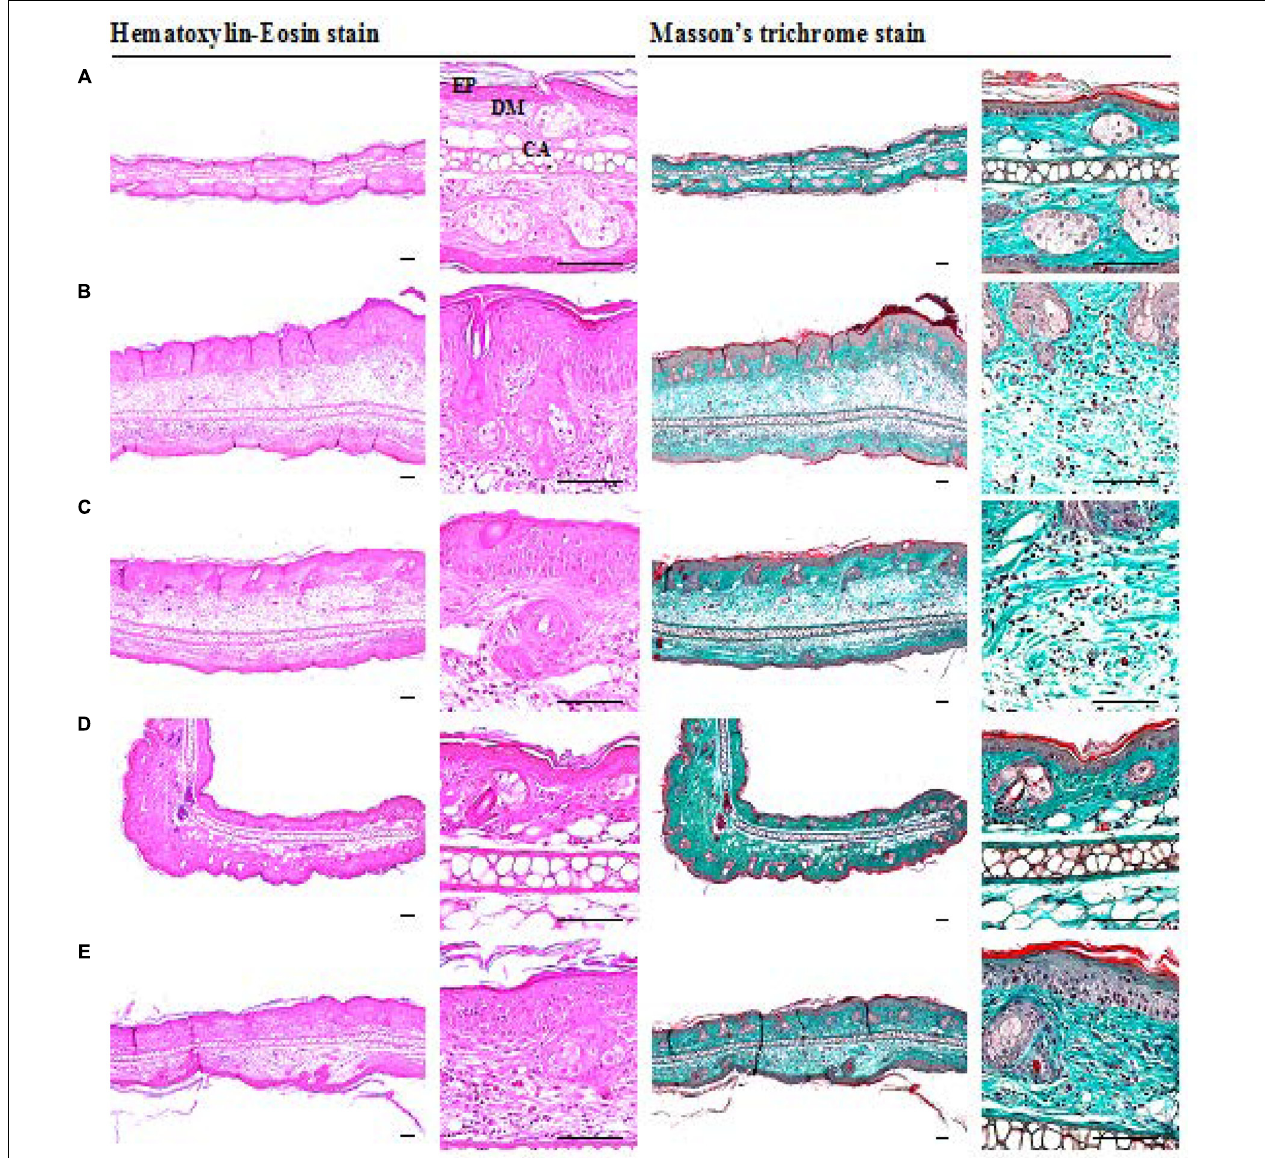
FIGURE 3 | Histopathological images of ear tissues of IMQ-induced psoriasis mice. (A) Control, (B) IMQ, (C) IMQ+vaseline, (D) IMQ+clobetasol, and (E) IMQ+SEL001. A noticeable increase of total and epithelial (epidermis) thicknesses, inflammatory cell infiltrations in the dermis, and decreases of dermis collagen fibers were observed in ear tissues of IMQ and IMQ+vaseline as compared with intact control, respectively. However, these IMQ-induced hypersensitive psoriasis related histopathological changes on the ear tissues were significantly inhibited by treatment of test material SEL001 and reference drug clobetasol in the current histopathological inspection. No meaningful histopathological changes in the ear tissues were demonstrated in IMQ+vaseline as compared with those of IMQ control [IMQ = Imiquimod; EP = Epithelium/Epidermis; DM = Dermis; CA = Ear